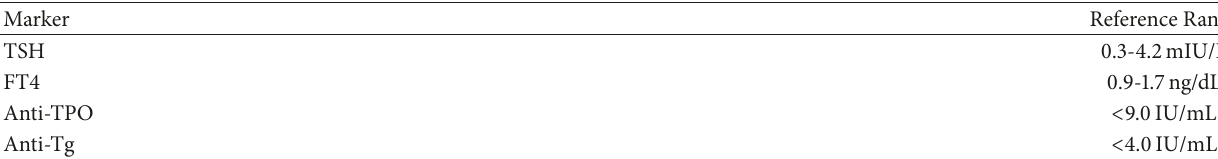
Table 2: Reference ranges for thyroid markers